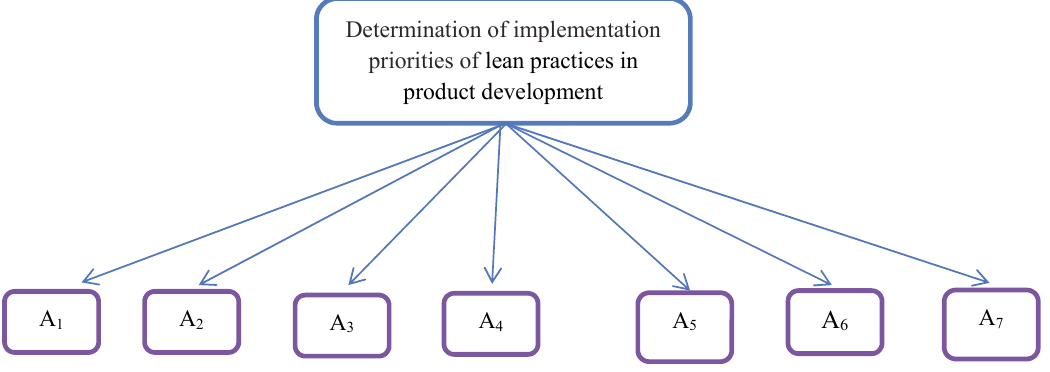
Fig. 1. Hierarchy model of lean implementation for the extended FAHP study